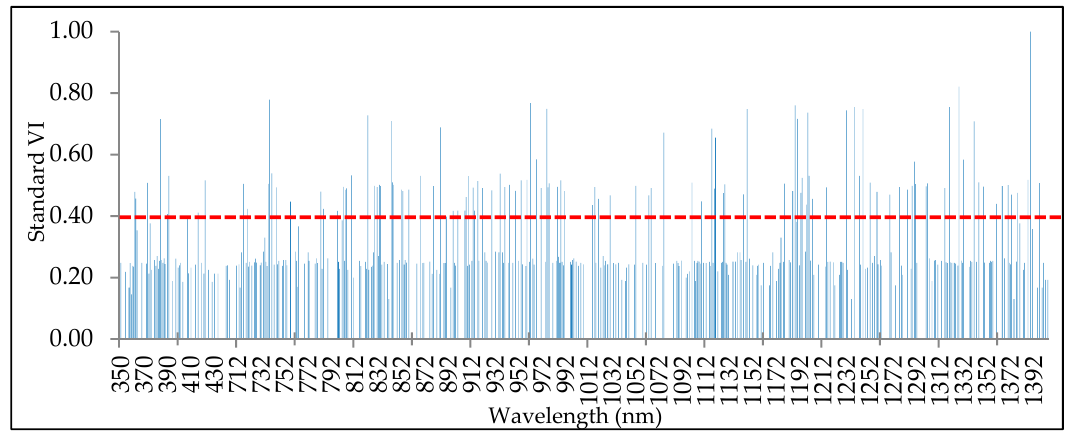
Figure 4. The results of random forest classifier (RFC) in introducing the most important wavelengths ( n = 118 where VI > 0.4), for the classification of almond, walnut, and grape species based on VI.